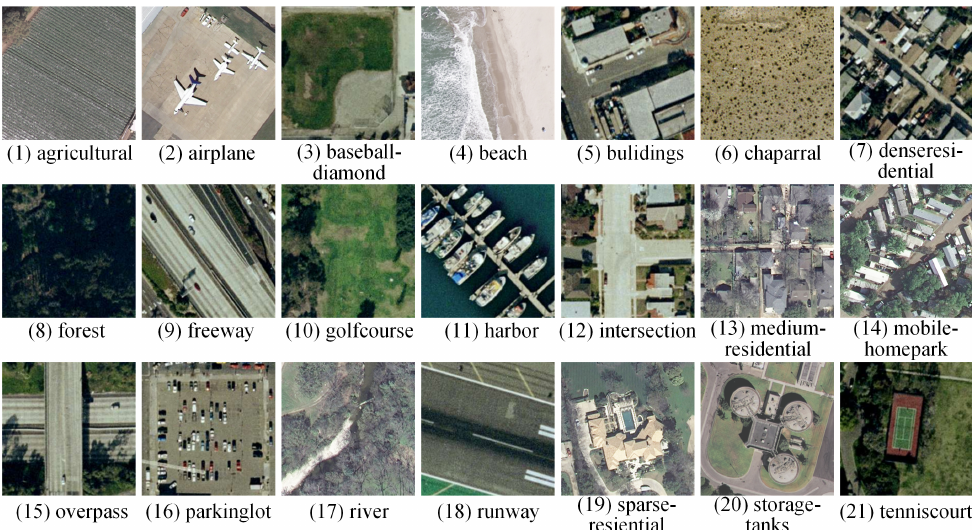
Figure 7. UC Merced dataset, the size of each scene image is 256 × 256, the resolution of images in this dataset is 0.3 m, and the 21 classes of this dataset include agricultural, airplane, baseball diamond, beach, buildings, chaparral, dense residential, forest, freeway, golf course, harbor, inter- section, medium density residential, mobile home park, overpass, parking lot, river, runway, sparse residential, storage tanks, and tennis